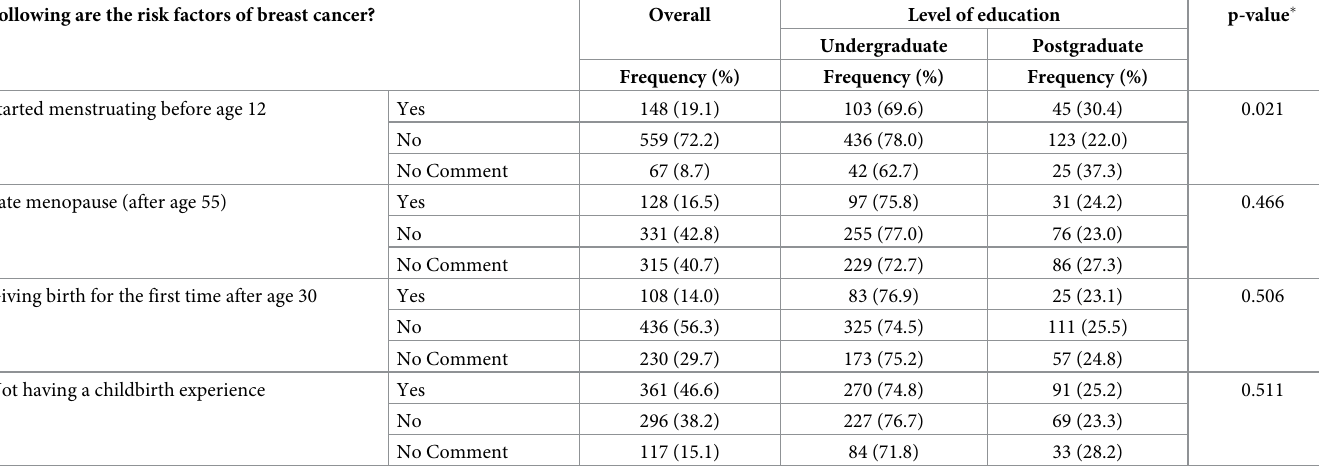
Table 3. Participant’s knowledge of breast cancer’s risk factors related to gynecological and obstetrics. Following are the risk factors of breast